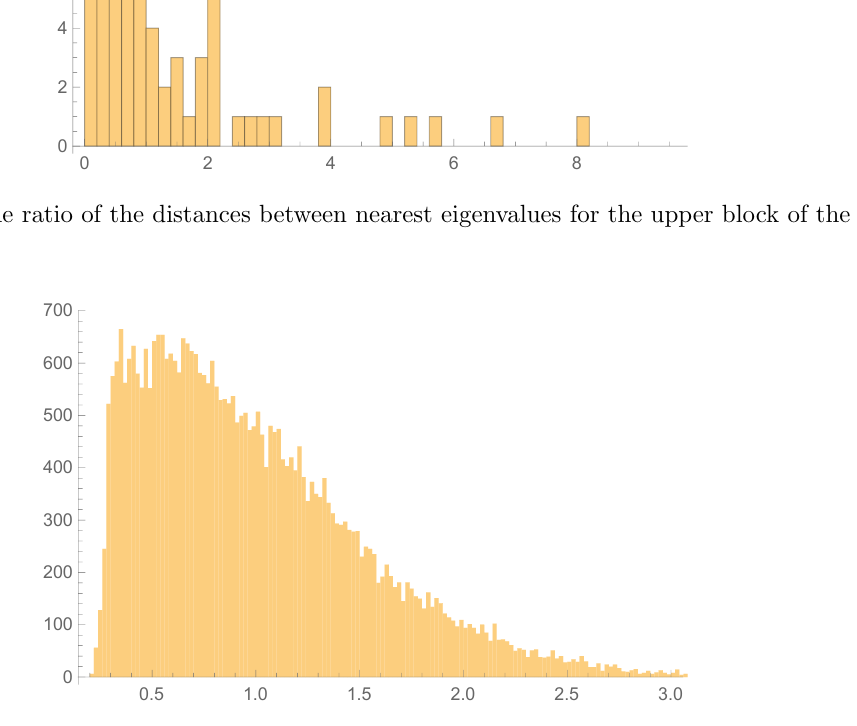
Figure 17 . The distribution of the unfolded level spacing for the full SYK